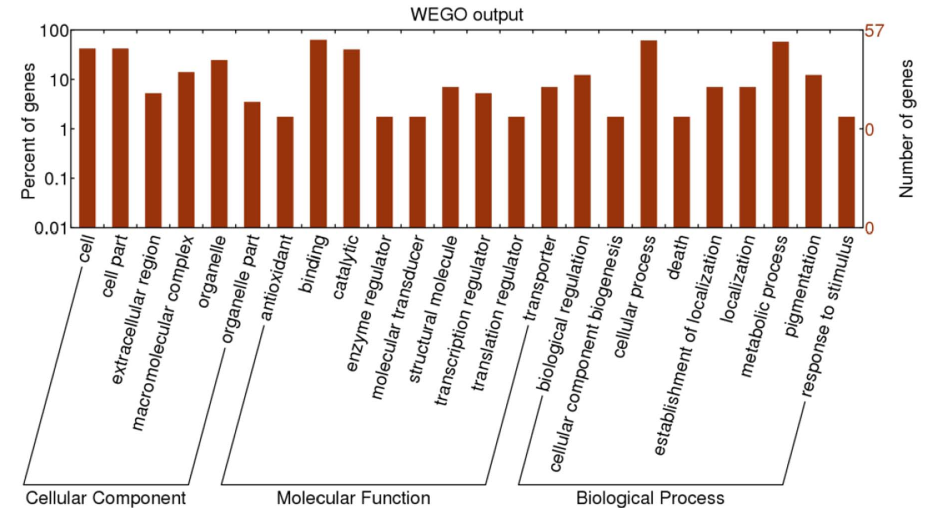
Figure 6. GO classification of 92 R9308-biased transcripts.